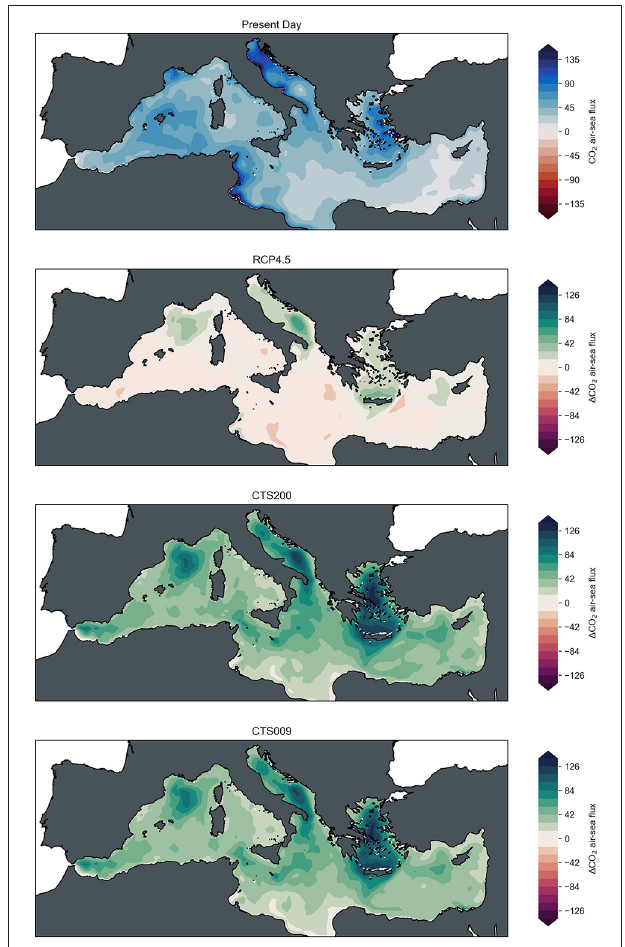
FIGURE 6 | Fields of mean CO 2 air-sea flux [mg m − 2 d − 1 ] for present day (2016–2020) and changes of mean fields at mid-century (2046–2050) with respect to present day conditions for RCP4.5 baseline scenario, CTS200 scenario and CTS009 scenario (from top to